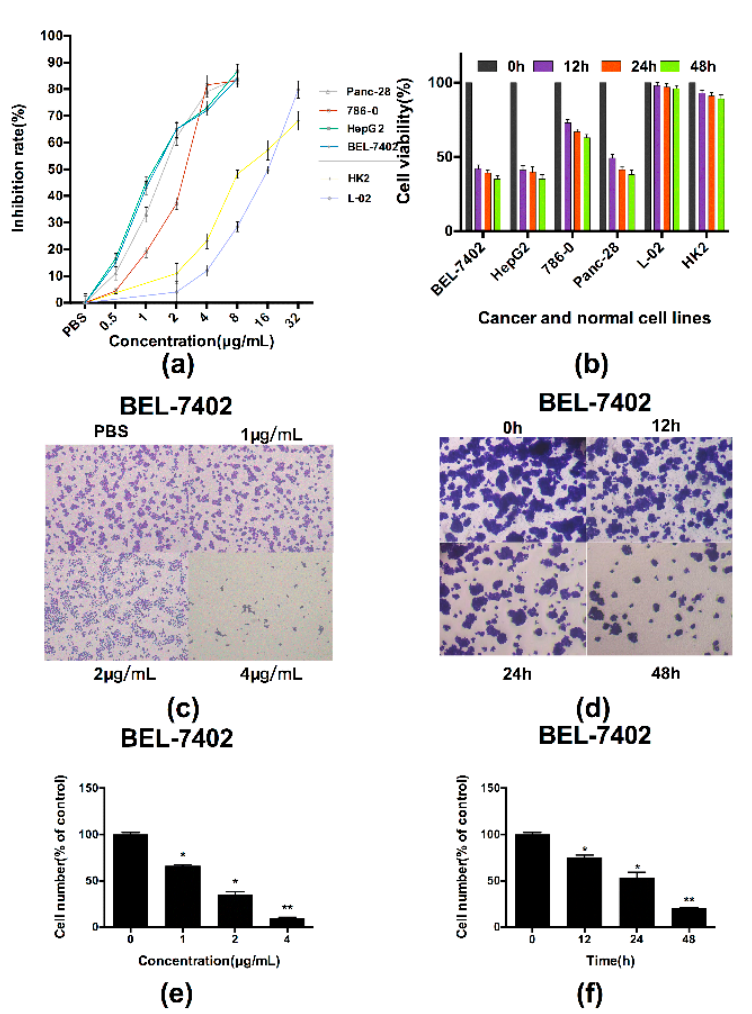
Figure 3. PBN11-8 displays potent cytotoxicity to cancer cells. ( a ) Cells were treated with certain concentrations of PBN11-8. The cell inhibitory rate was determined by MTT assay as described in the experimental section. The IC 50 values were 1.56, 1.80, 1.57 and 1.73 µg/mL for BEL-7402, 786-0, HepG2 and Panc-28 cells, respectively. The IC 50 values were 11.79 and 14.72 µg/mL for HK2 and L02 cells, respectively. ( b ) Cells were cultured in 96-well plate and treated with 4 µg/mL PBN11-8 for each cell lines for 0,12, 24, and 48 h to study the time dependent analysis. The cell viability was analyzed by MTT assay. ( c ) The results of the crystal violet adhesion assay in BEL-7402 cells induced by 1, 2, 4 µg/mL of PBN11-8 for 12 h. ( d ) The results of the crystal violet adhesion assay in BEL-7402 cells induced by 2 µg/mL of PBN11-8 for 12, 24 and 48 h. ( e , f ) The quantitative evaluations of the crystal violet adhesion assay. Data represent the mean ± SD of three independent experiments. * p < 0.05 vs. control; and ** p < 0.01 vs. control. The authors apologize for any inconvenience caused and the change does not affect the scientific results. The manuscript will be updated, and the original will remain online on the article webpage at https://www.mdpi.com/2073-4360/10/9/1043.